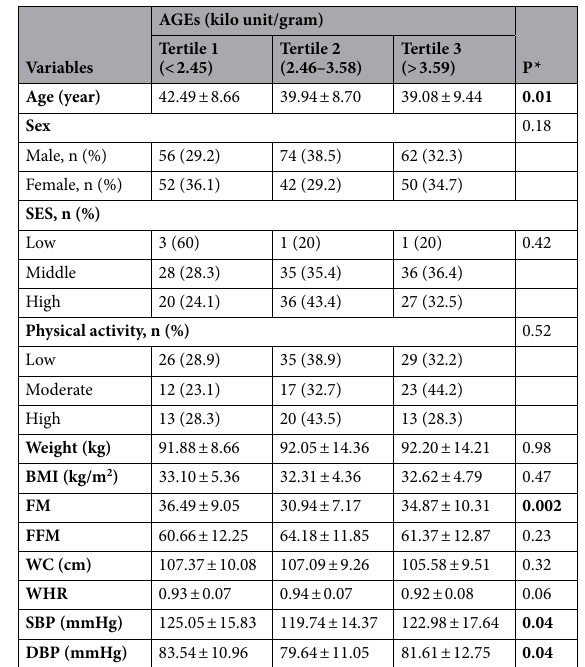
Table 1. Comparison of demographic characteristics and anthropometric values in AGEs tertiles. SES Socio- economic status, BMI Body Mass Index, FM Fat Mass, FFM Fat free mass, WC Waist Circumference, WHR Waist-to-Hip ratio, SBP Systolic Blood Pressure, DBP Diastolic Blood Pressure; values are presented based on mead (SD). Comparison was done using chi-square and One-Way ANOVA. *P values based on ANCOVA adjusted for age and sex. Bold values provide the significant threshold of P <